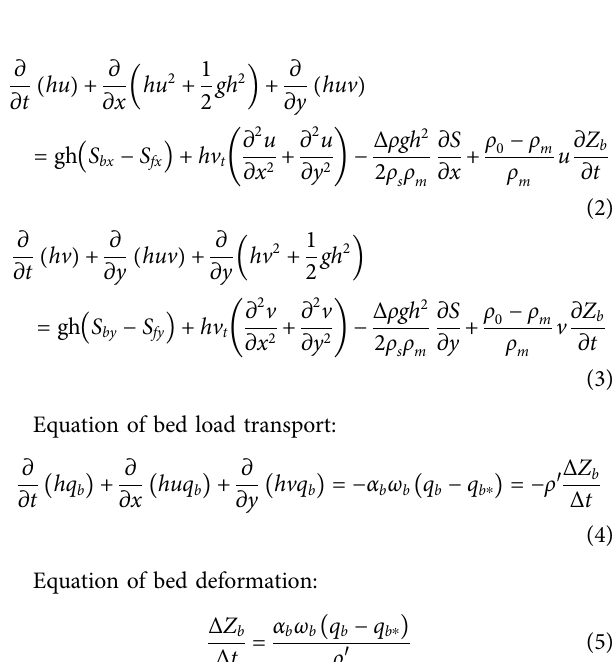
FIGURE 1 | Satellite image of the Zhongdu River and Zhongdu Town.